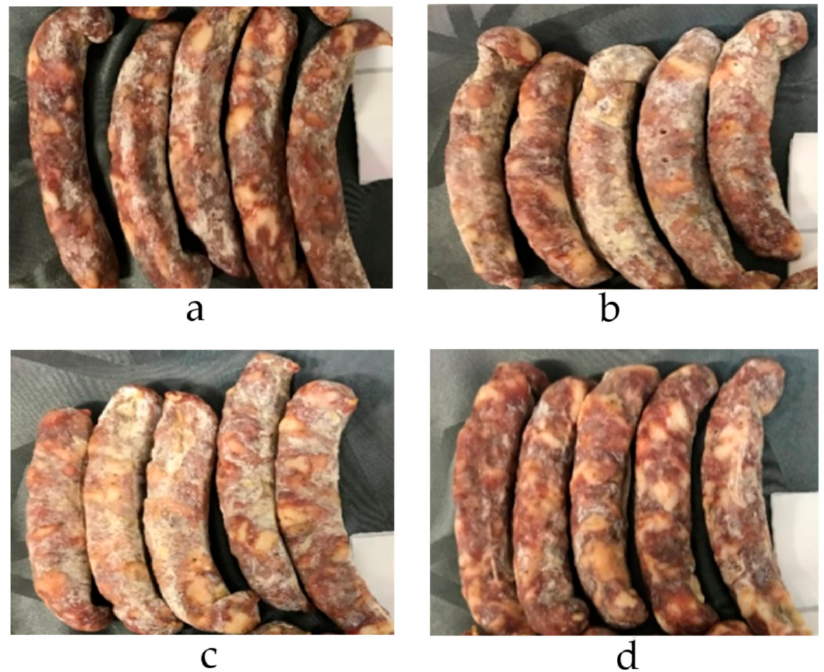
Figure 4. Surface mold covering of sausages (( a ) = control with 110 mg/kg sodium nitrite and 0.2% phosphates; ( b ) = 50% less sodium nitrite than in control; ( c ) = 50% less sodium nitrite than in control with added 225 mg/kg sodium ascorbate; ( d ) = no phosphates and 110 mg/kg sodium nitrite).